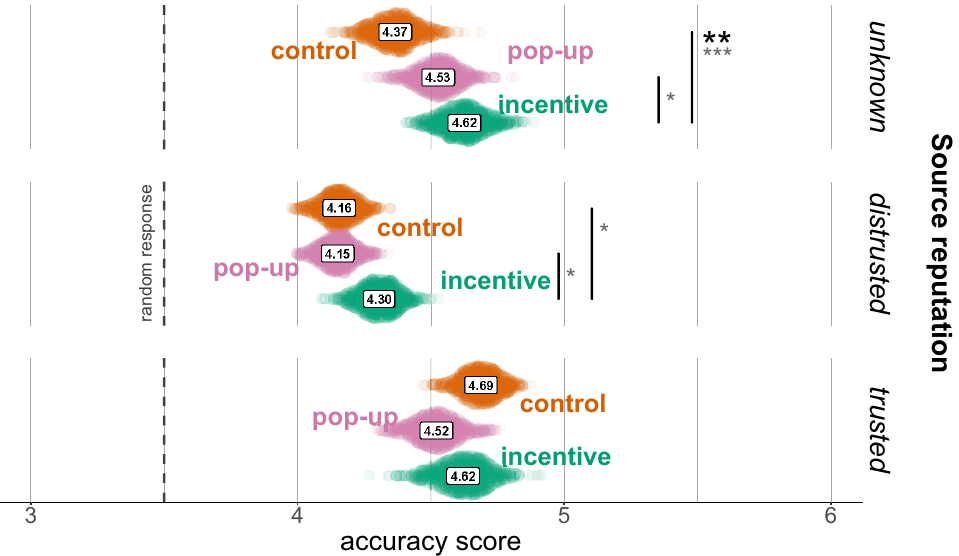
Figure 4. Bootstrap estimates of the average accuracy score by experimental condition and source reputation (Min. 1, Max. 6, random response: 3.5). Asterisks refer to significance of contrasts in the ordinal logistic regression. Black: family-wise corrected contrasts; dark grey: uncorrected contrasts. * p < 0.05 , ** p < 0.01 , *** p < 0.001